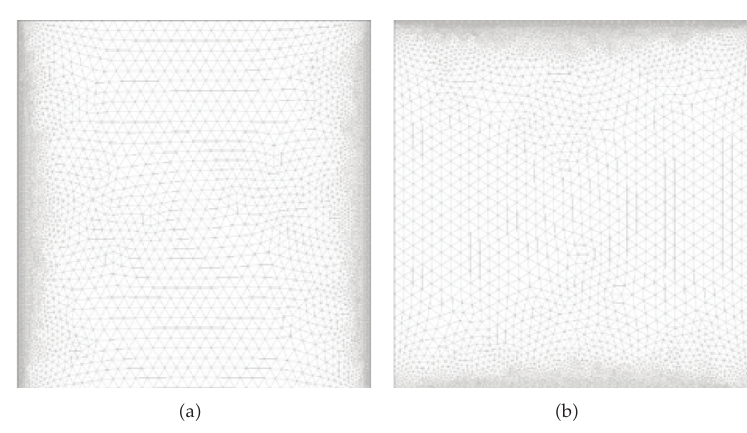
Figure 2: Mesh distribution for: (cid:3) a (cid:4) Case 1, (cid:3) b (cid:4) Cases 2 and